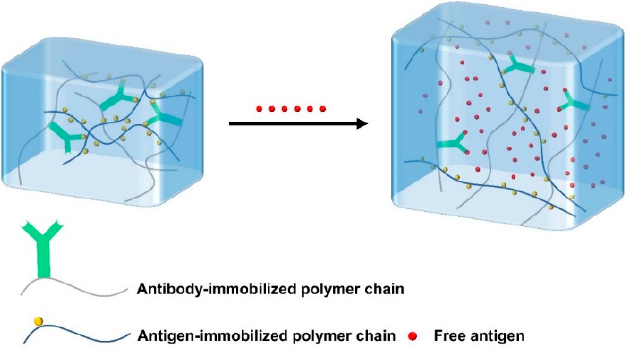
Figure 4. Schematic of the antigen-responsive hydrogels. The free antigens in the environment compete with the binding antigens in the hydrogel, resulting in the decrease of crosslinking density and swelling of the hydrogel.